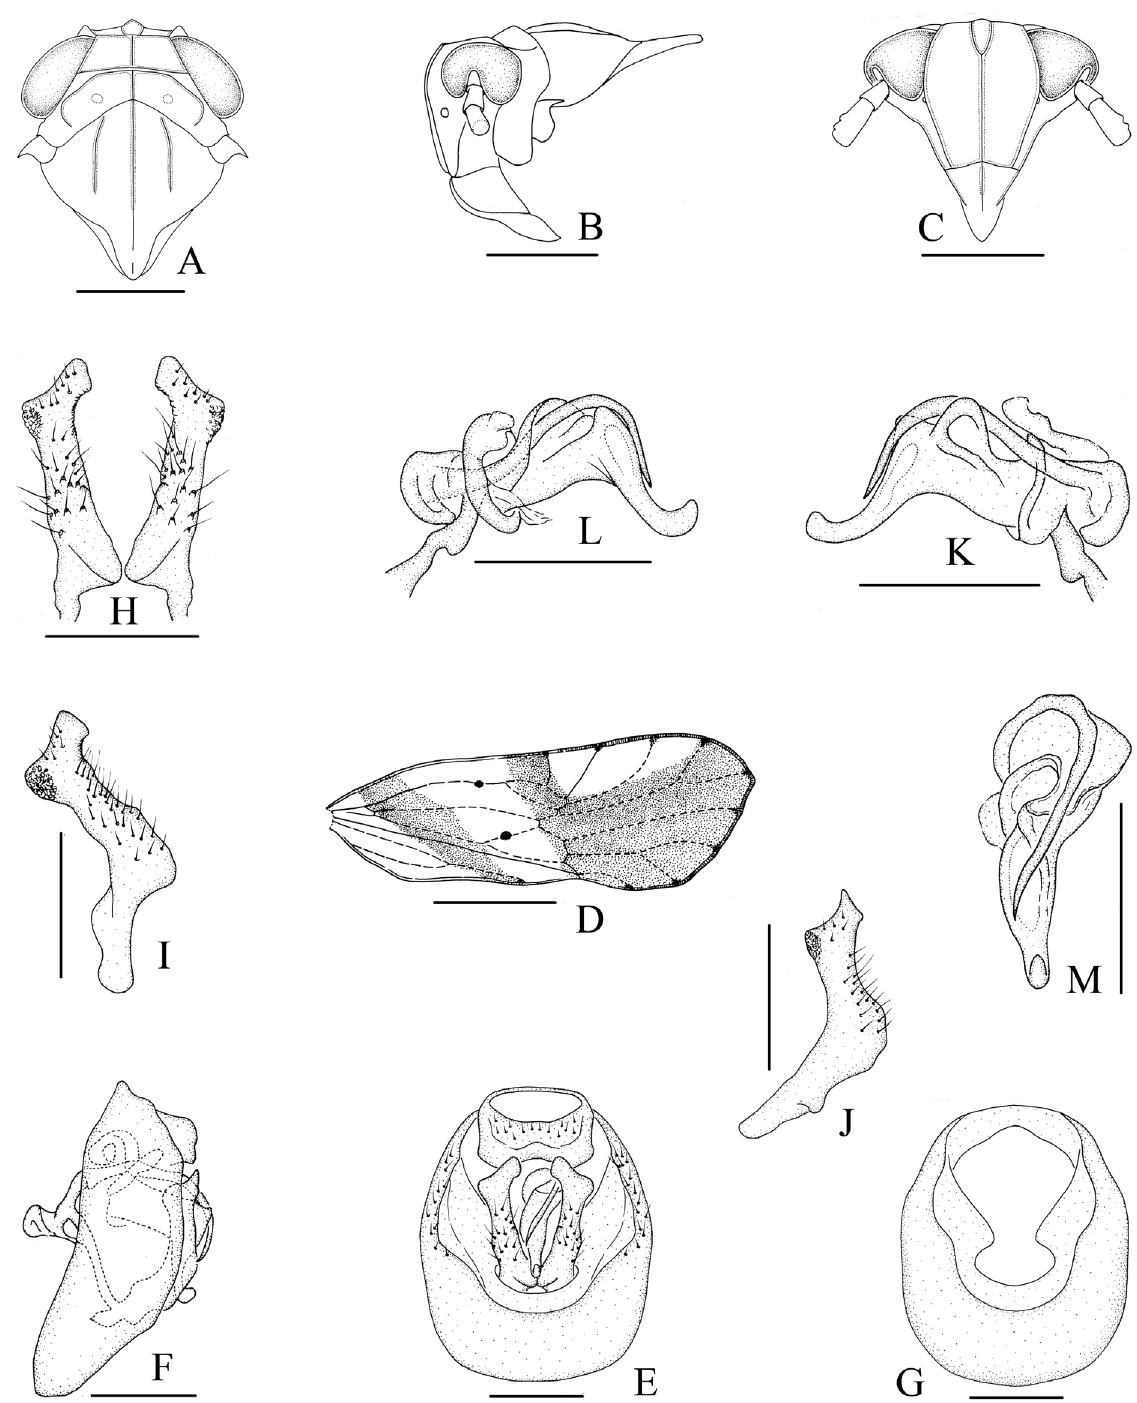
Fig. 2. Arcofaciella indiana sp. nov., holotype, ♂ (GUGC-FDTA-19720801). A . Head and thorax, dorsal view. B . Same, lateral view. C . Face. D . Forewing. E . Male genitalia, posterior view. F . Same, lateral view. G . Pygofer, posterior view. H . Genital style, posterior view. I . Same, posterior and lateral views. J . Same, lateral view. K . Aedeagus, right lateral view. L . Same, left lateral view. M . Same, dorsal view. Scale bars: A–C = 0.5 mm; D = 1 mm; E–M = 0.2